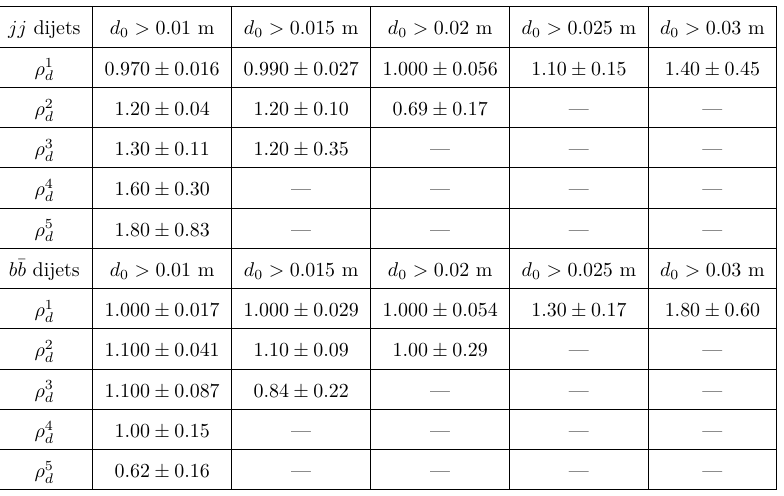
Table 2 . The correlation (including the statistical uncertainty) from our simulation, for multiple d 0 tracks for QCD dijet backgrounds after applying vertexing-cuts . For the entries with “—”, there are not enough statistics to make a reliable estimate. For higher tracks multiplicity and d 0 threshold, the results suffer from larger fluctuations due to limited